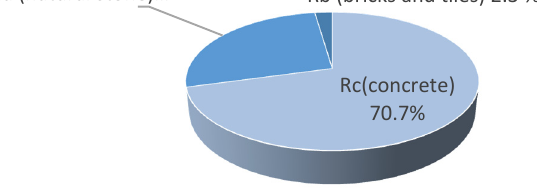
Figure 4. Coarse recycled aggregates composition according to EN 933-11:2009 [40].